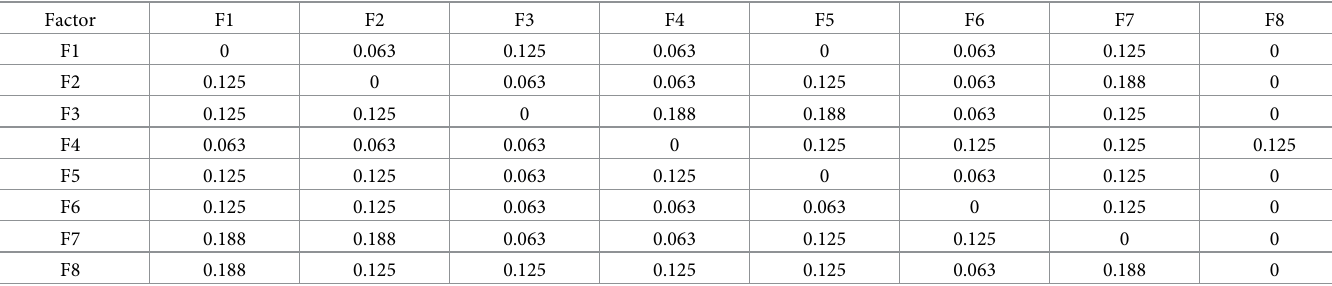
Table 3. Normalized—Direct—Influence matrix (X).